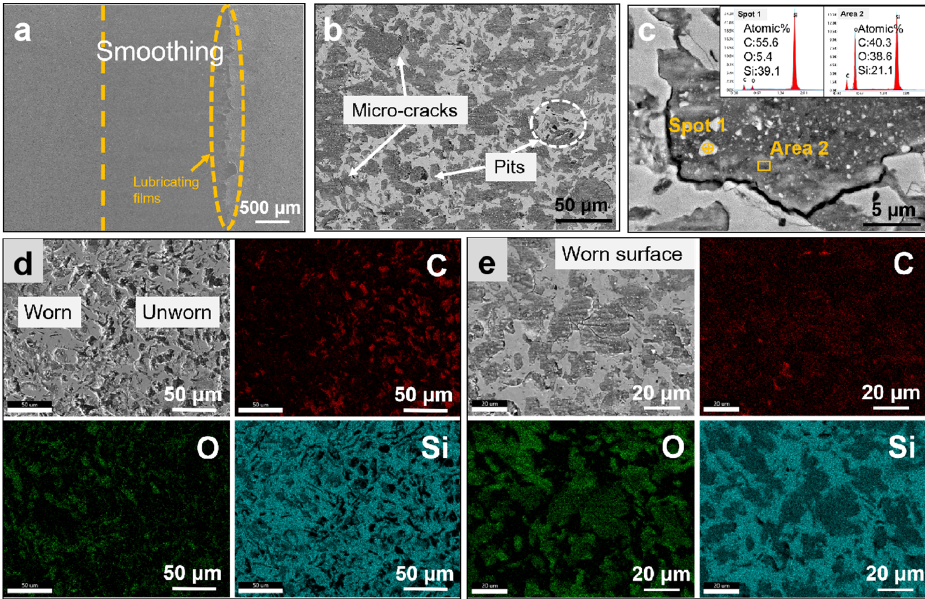
Figure 8. Friction surface morphology of M-MS composites: ( a ) low magnification; ( b,c ) high mag- nification; ( d,e ) EDS analysis.